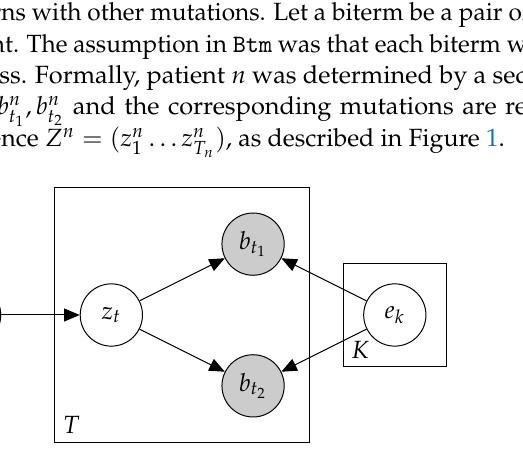
Figure 1. A plate diagram for Btm